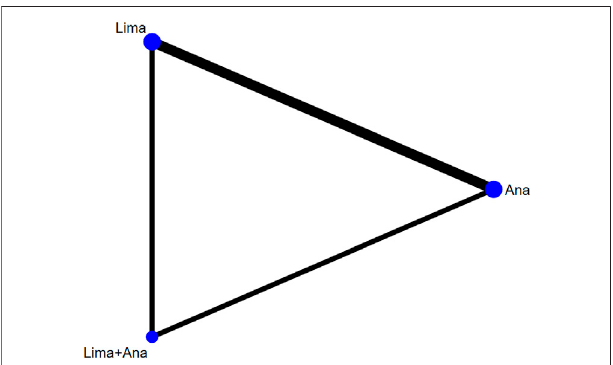
FIGURE 8 | Network plot for included studies on